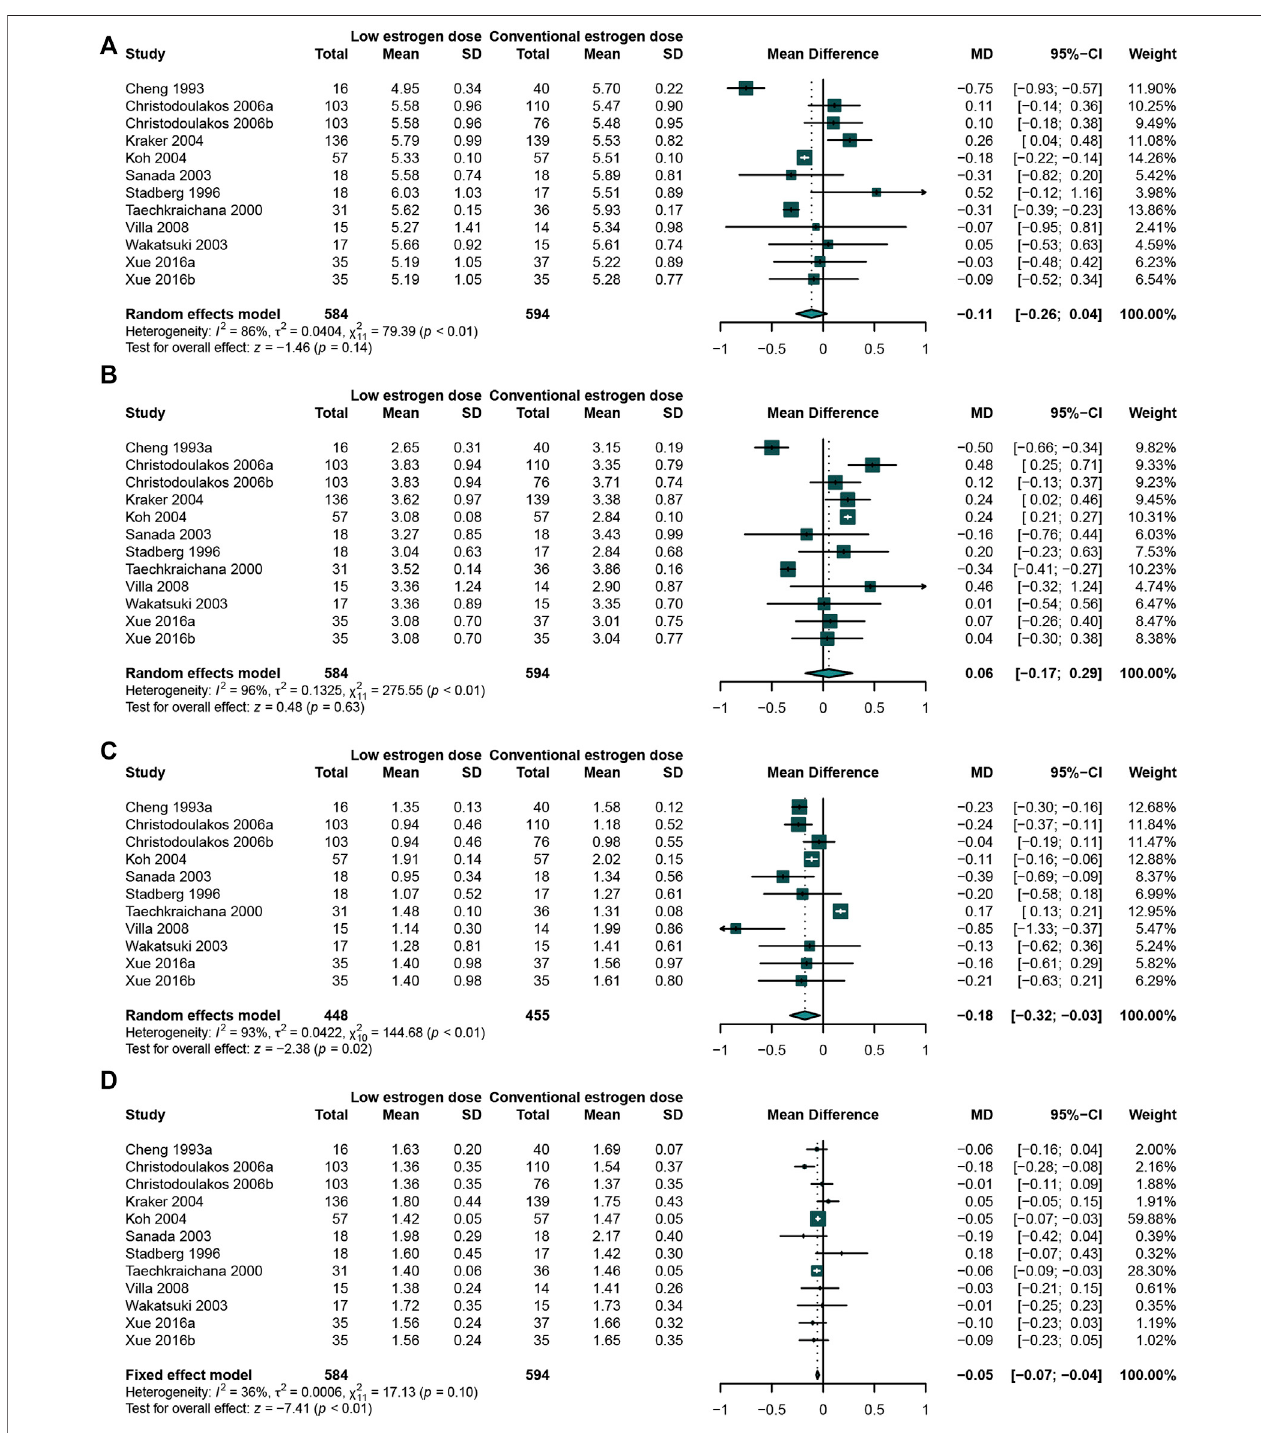
FIGURE 6 | Studies comparing low-dose estrogen with conventional-dose estrogen. A low-dose estrogen led to a signi fi cant reduction in TG concentration comparedwithaconventional-dose estrogen. (A) TCconcentration; (B) LDL-C concentration; (C) TGconcentration; (D) HDL-C concentration; (E) Lp(a) concentration.